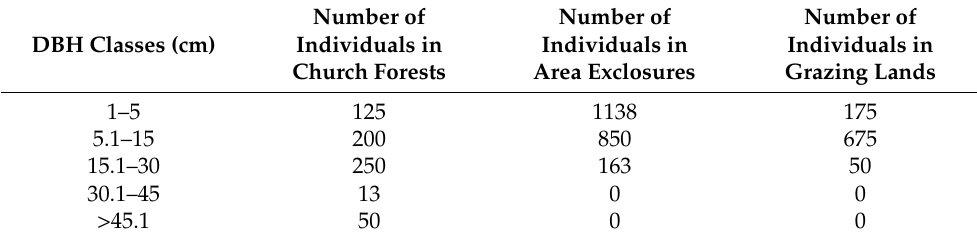
Table 4. Population status in different DBH classes in mid-altitude study areas. Number of DBH Classes (cm) Individuals in Church Forests